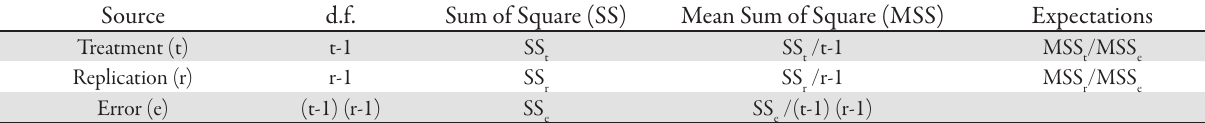
Tab. 3. Analysis of